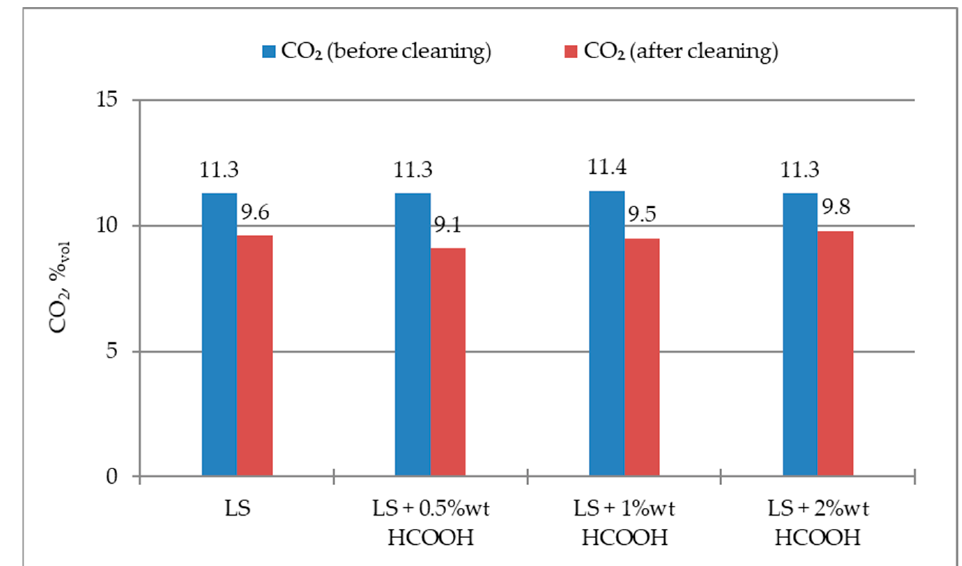
Figure 4. CO 2 values before and after flue gases